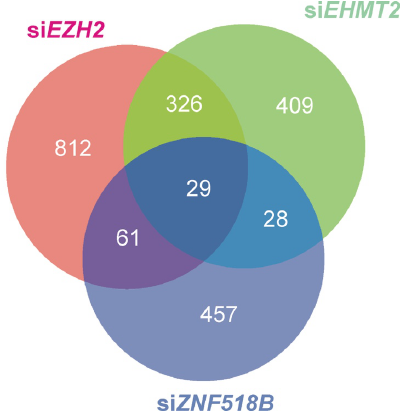
Figure 4. Venn diagram showing the genes whose expression is affected in common by the knocking down of ZNF518B , EZH2 and/or EHMT2 in the colorectal cancer (CRC) HCT116 cell line. There were 118 genes affected in common by ZNF518B , EZH2 and/or EHMT2 (Sup- plementary Table S5). Among these genes, we first selected those inhibited by EZH2 and/or EHMT2 . Then, we crossed the resulting list with that of the genes inhibited by ZNF518B . Obviously, the final list contained all the candidate genes to be inhibited by ZNF518B in combination with EZH2 and/or EHMT2 . Finally, by analysing the published effects of these genes, we selected those displaying suppressor properties. In this way, the genes selected for ChIP analysis were: PADI3 , a tumour suppressor in CRC [31], ZDHHC2 , a suppressor of metastasis in hepatocellular carcinoma [32] and RGS4 , which inhibits the growth of human breast carcinoma cells [33]. Two other genes, namely EF- NA5 and KAT2B , were also selected for ChIP analysis in view of their potential oncolog- ical relevance, although the cut-off value used to construct the list of Supplementary Ta- ble S5 did not allow for their inclusion. The first one of these two additional genes has been previously reported as a suppressor in CRC [34,35], while the second one codes for the histone acetyltransferase PCAF, which has been described as an inhibitor of hepato- cellular carcinoma [36]. The inclusion of KAT2B was further substantiated by the fact that it is one of the more connected nodes in the protein–protein interaction network (Sup- plementary Figure S4) obtained by in silico analysis, as described under Materials and Methods. The consequences of silencing ZNF518B on the expression of these genes were first validated by RT-qPCR in HCT116 cells (Figure 5A), in which the in silico analysis of the effects of silencing EZH2 and EHMT2 was done. As a further verification, we compared the expression levels of these genes in RKO cells transfected with pCMV3- ZNF518B or with the empty plasmid. As these genes were activated by silencing ZNF518B , it was expected that the overexpression of the latter resulted in the inhibition of the selected genes, and the experimental results confirmed this idea (Figure 5B).